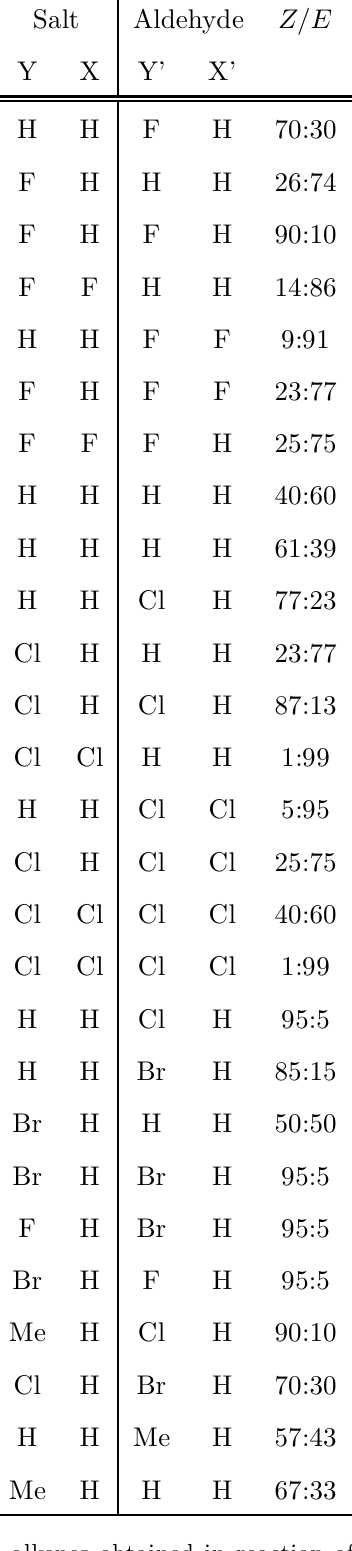
Table 4 The Z=E ratio of the alkenes obtained in reaction of o; o ` ¡ substituted benzyltriph- enylphosphonium bromides with substituted